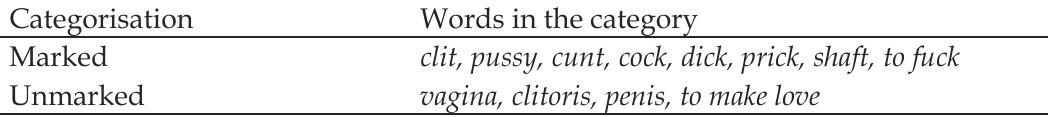
Categorisation of taboo vocabulary from the English corpus Categorisation Words in the category Marked clit, pussy, cunt, cock, dick, prick, shaft, to fuck Unmarked vagina, clitoris, penis, to make love Source: own